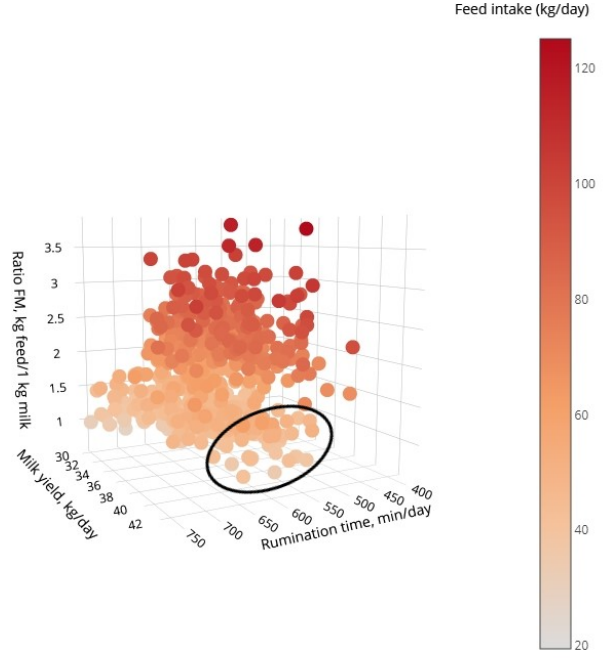
Figure 2. Association of milk yield, rumination time, and FCR (feed conversion efficiency per 1 kg milk) in the range of 31 to 209 days in milk and milk yield ≥ 30 kg/day; milk yield: mean ± SD = 34.5 ± 3.1 kg/d, rumination time: mean ± SD = 588 ± 65 min/d, FCR: mean ± SD = 1.80 ± 0.62 kg feed/1 kg milk; the black circle includes the highest yielding and feed efficient cows.